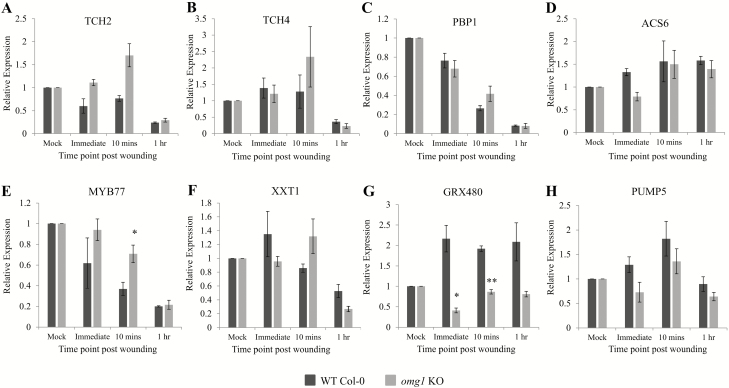

OMG1 regulates the rapid wounding response of MYB77 and GRX480. WT Col-0 and omg1 KO intact leaf tissues were untouched (mock) or wounded with a pair of forceps and left for the indicated time points before harvesting for qRT-PCR analyses. Expression of the indicated genes (A–H) shared between spaceflight, rapid wounding and pollen development [seeSupporting Information—Table S2] in the WT (Col-0) and omg1 KO leaves was analysed. Untouched leaves (mock), immediately after wounding, 10-min post-wounding and 1-h post-wounding were the indicated time points that the transcripts were measured. The average relative expression was normalized to a housekeeping gene (UBQ11) and presented relative to the mock controls. * indicate significance (P < 0.05), ** (P < 0.001) between WT Col-0 and omg1 which was calculated by doing a two-factor ANOVA followed by post hoc Student’s t-test. All error bars represent the standard error of the mean of triplicate representative experiments.